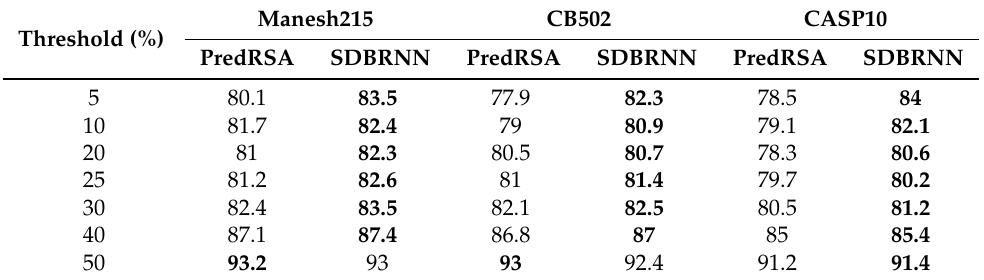
Table 4. Accuracy (%) performance comparison in binary classification prediction (the best results are shown in